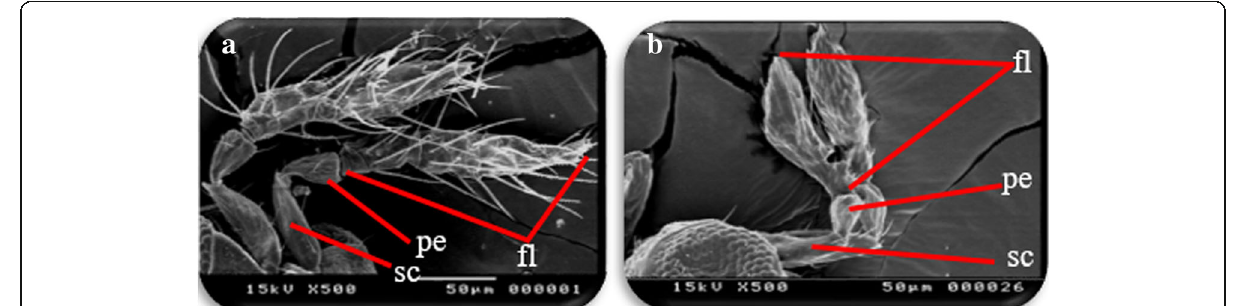
Fig. 3 The antennae of male and female of TNV: a , b SEM of male and female. fl flagellum, pe pedicel, sc